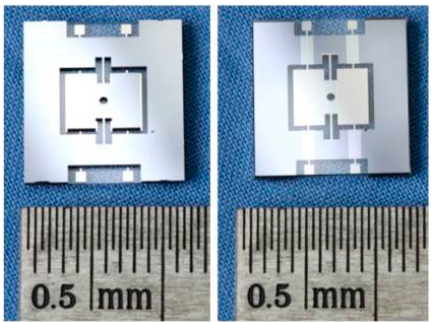
Figure 4. The frontal and rear photos of bonded microstructure.